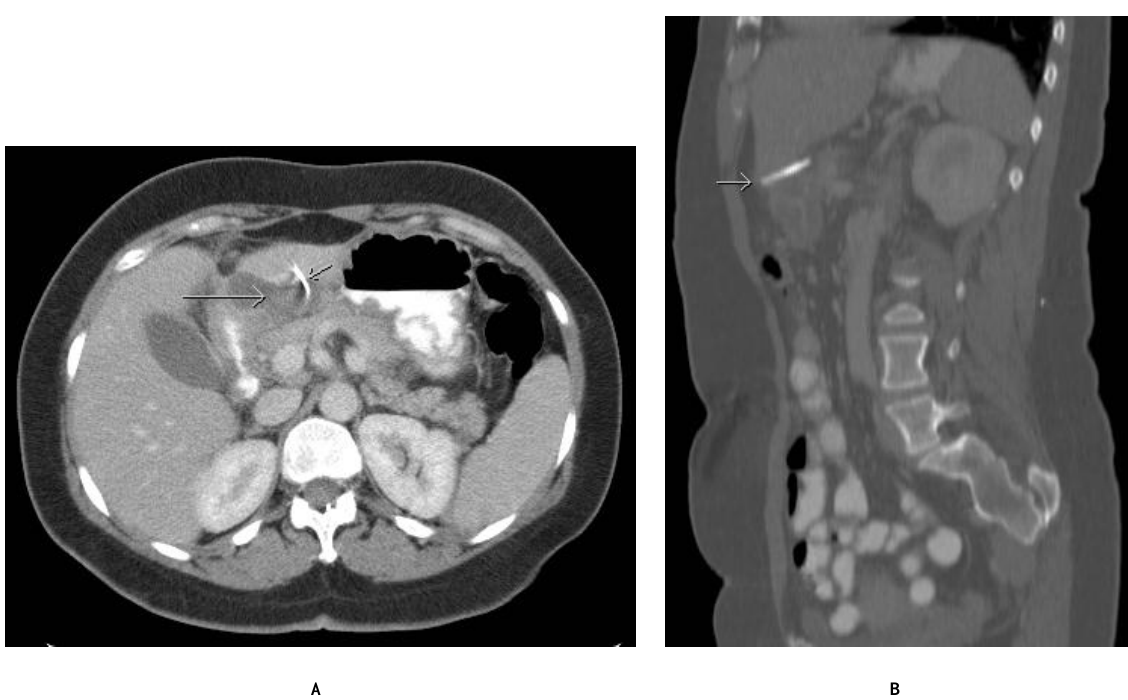
FIGURE 1. (A,B) Abdominal CT scan showing a foreign body perforating through the duodenum in the left liver lobe (small arrows) and a liver abscess (big